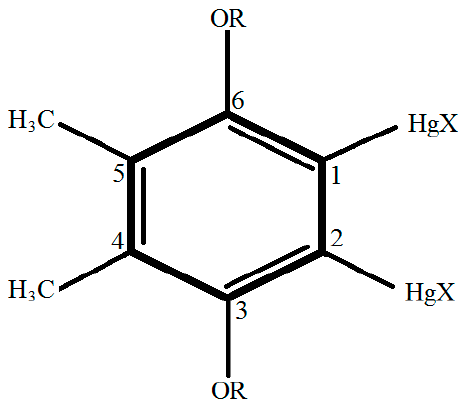
Figure 1. The mercury organic ionophore structure (ETH9033) [10].